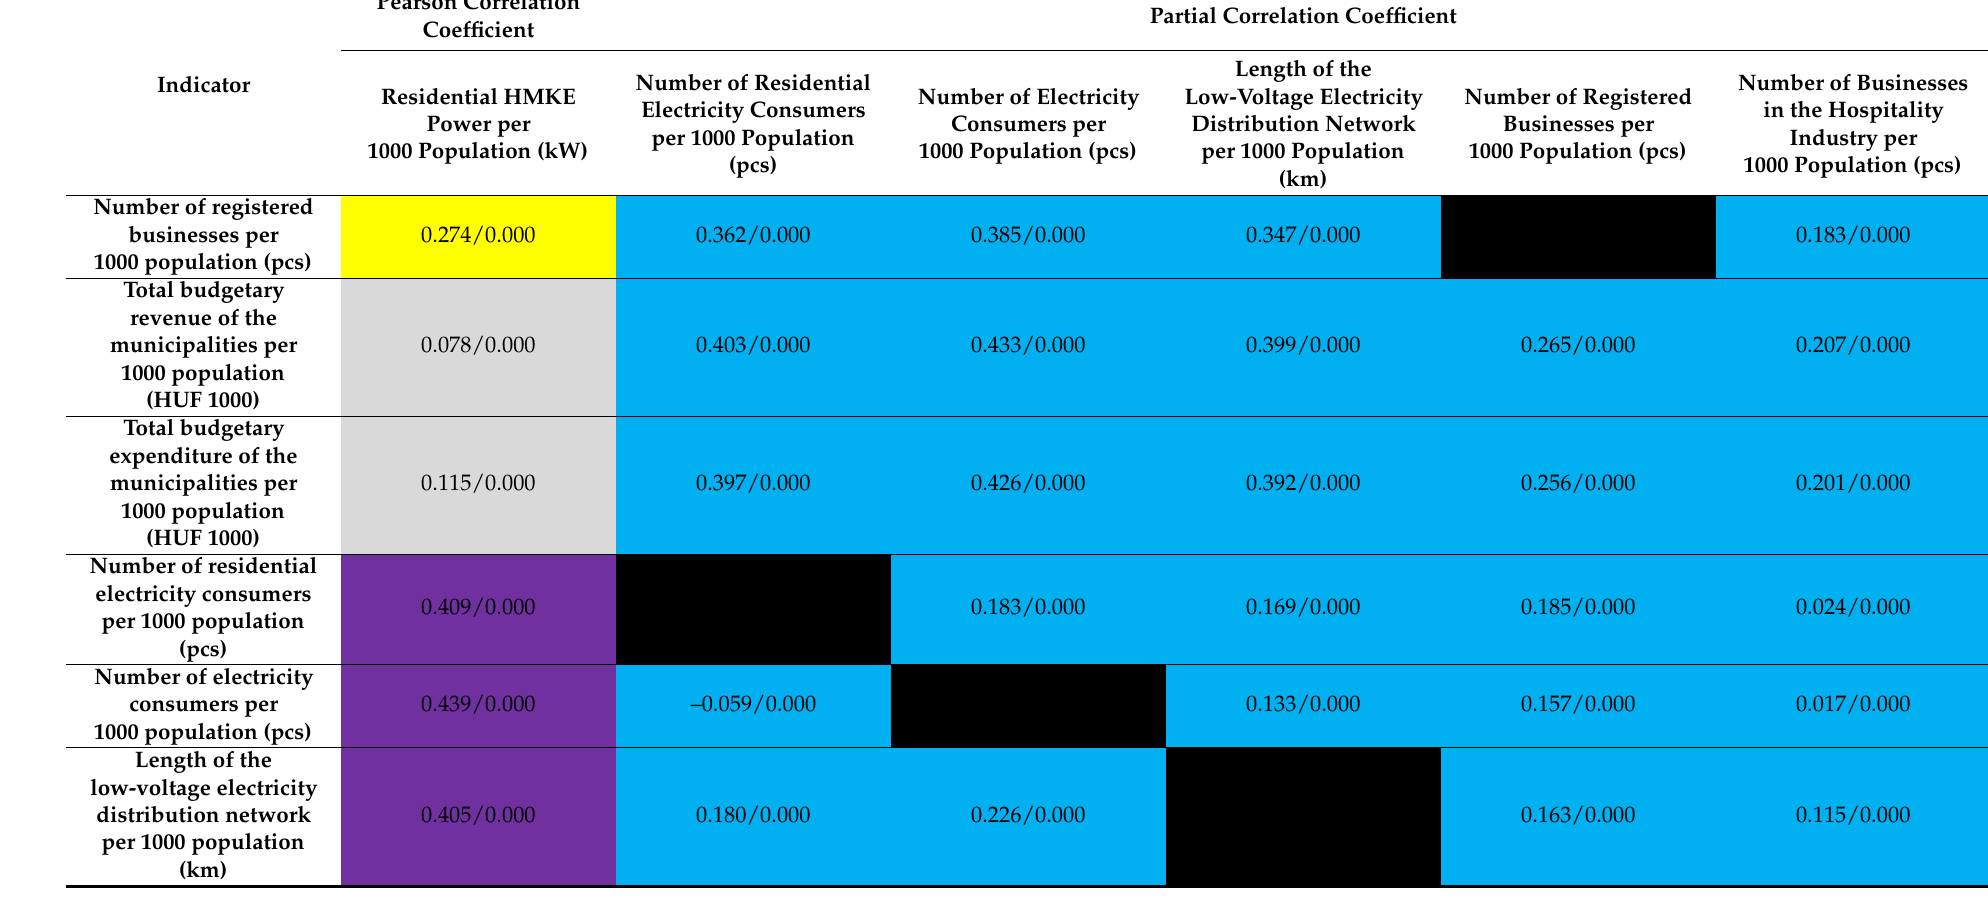
Table A2. The strengths of the relationships between the power of the residential HMKEs per 1000 population and the settlement indicators 1 ( 1 Pearson correlation coefficient/ p -value; if p < 0.05, then there is a significant verified relationship between the two variables) (In the case of the Pearson correlation coefficients in the table grey background indicates weak correlations, yellow means weak moderate, and purple moderately close ones. In the case of the partial correlation the blue background signals partial explanation (the controlled variable explains the relationship between variables i and j only partially), while the black one shows irrelevant